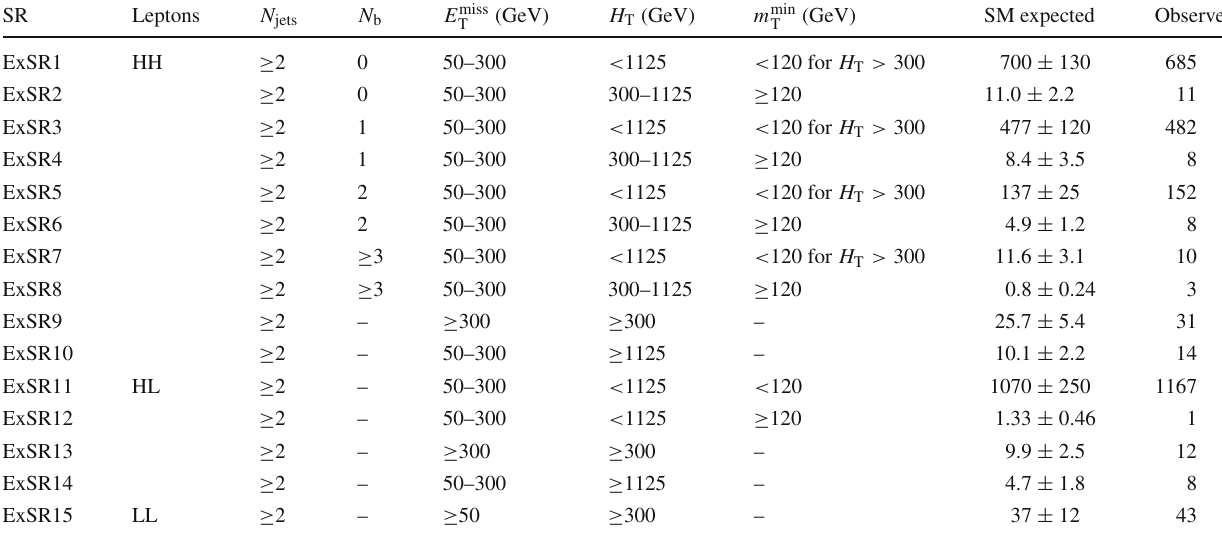
Table 8 Exclusive SR definitions, expected background yields, and observed yields. A dash (–) means that the selection is not